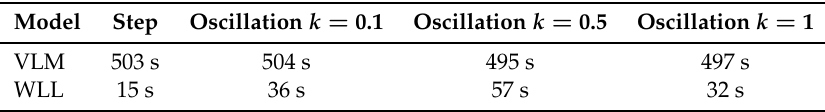
Table 1. Computation time comparison between VLM and